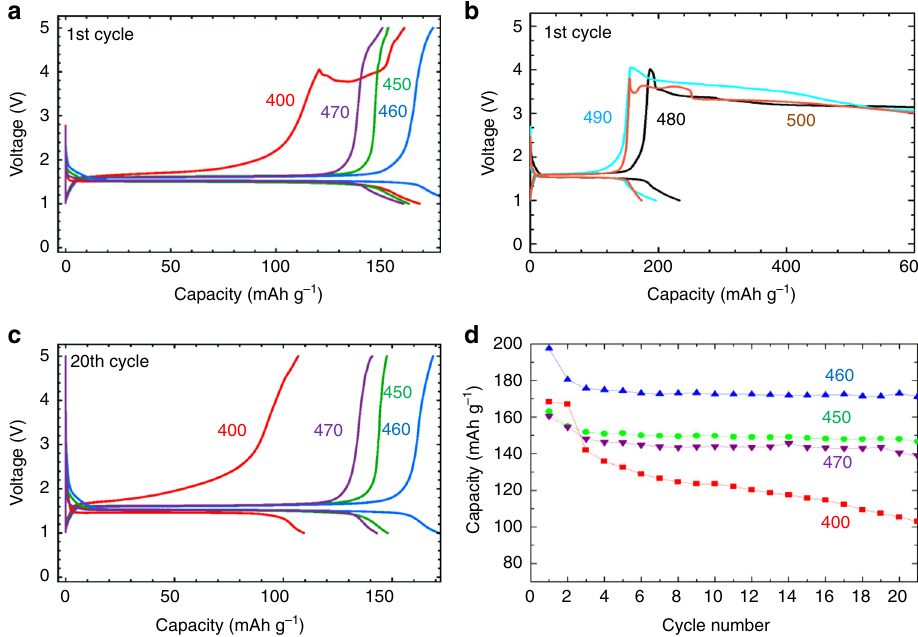
Fig. 4 Battery performance of Li 4 Ti 5 O 12 + LSPS-Cl + C/LSPS-Cl/glass fi ber/Li cells incorporating different LSPS-Cl materials annealed at different temperatures. a First and 20th-cycle charge/discharge curves for batteries incorporating medium- and minor-decomposition materials (LSPS 400,450 – 470). b First-cycle charge/discharge curves for batteries incorporating severe-decomposition materials (LSPS 480 – 500). c 20th-cycle charge/ discharge curves for batteries incorporating (LSPS 400,450 – 470). d Cycle performance of the batteries incorporating LSPS 400,450, 460, and 470